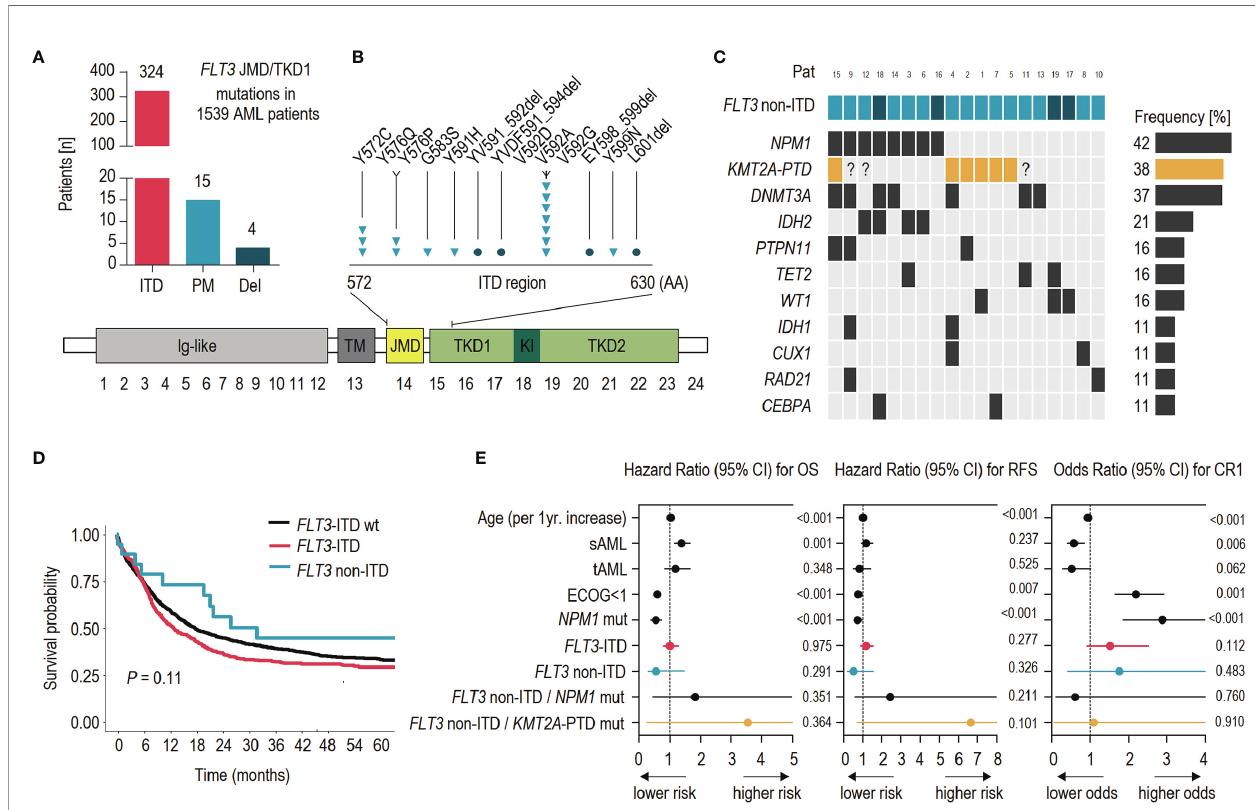
FIGURE 1 | Clinical and molecular associations of FLT3 non-ITD mutations in AML. (A) Frequencies of molecular alterations detected in the FLT3 JMD/TKD1 region of 1,539 AML patients: ITD, (internal tandem duplication); PM, (point mutation); and Del, (deletion). (B) Schematic illustration showing the position of acquired FLT3 non-ITD mutations (triangles = point mutations, circles = deletions) and the domain structure of FLT3 : lg-like, (ligand binding domain); TM, (transmembrane domain); JMD, (juxtamembrane domain); TKD1, (tyrosine kinase domain-1); KI, (kinase insert); TKD2, (tyrosine kinase domain-2). (C) Associated co-mutations in FLT3 non-ITD patients. KMT2A -PTD data are available for 16/19 patients with FLT3 non-ITD mutation. Genes with <10% mutation rate are not shown: EZH2 , ASXL1 , IKFZ1 , NRAS , RUNX1 , SRSF2 , TP53 . (D) Kaplan – Meier analysis showing the probability of overall survival (OS) for AML patients without molecular alterations in the FLT3 -ITD region (wt; n = 1,196; black), ITD mutation (n = 324; red), and non-ITD mutation (n = 19; blue). (E) Results of the multivariable analysis of prognostic factors for overall survival, (OS); relapse-free survival, (RFS) and complete remission,